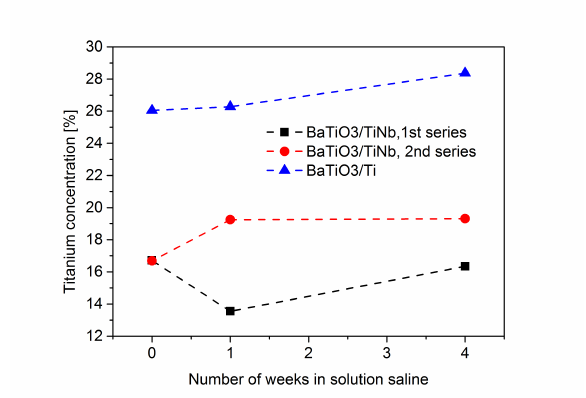
Figure 3. Titanium concentration due to an action of solution